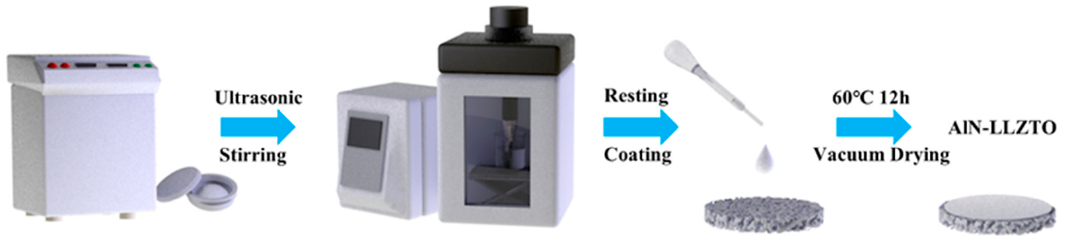
Figure 1. Schematic illustration of AlN coated LLZTO.